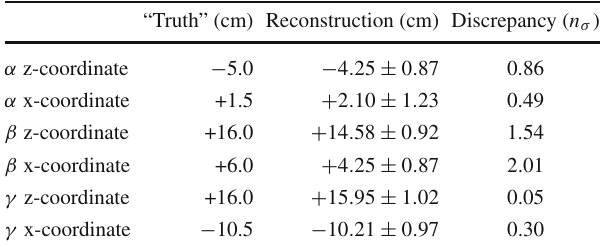
Table 2 Reconstruction of the edge points in a neutrino-event (Fig.8). The reconstruction errors are calculated according to formula (5.7) “Truth” (cm) Reconstruction (cm) Discrepancy ( n σ